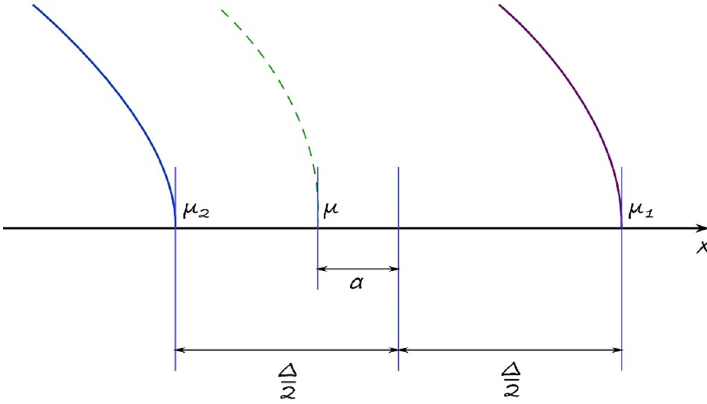
p (cid:21)= 2 (cid:25) (see also